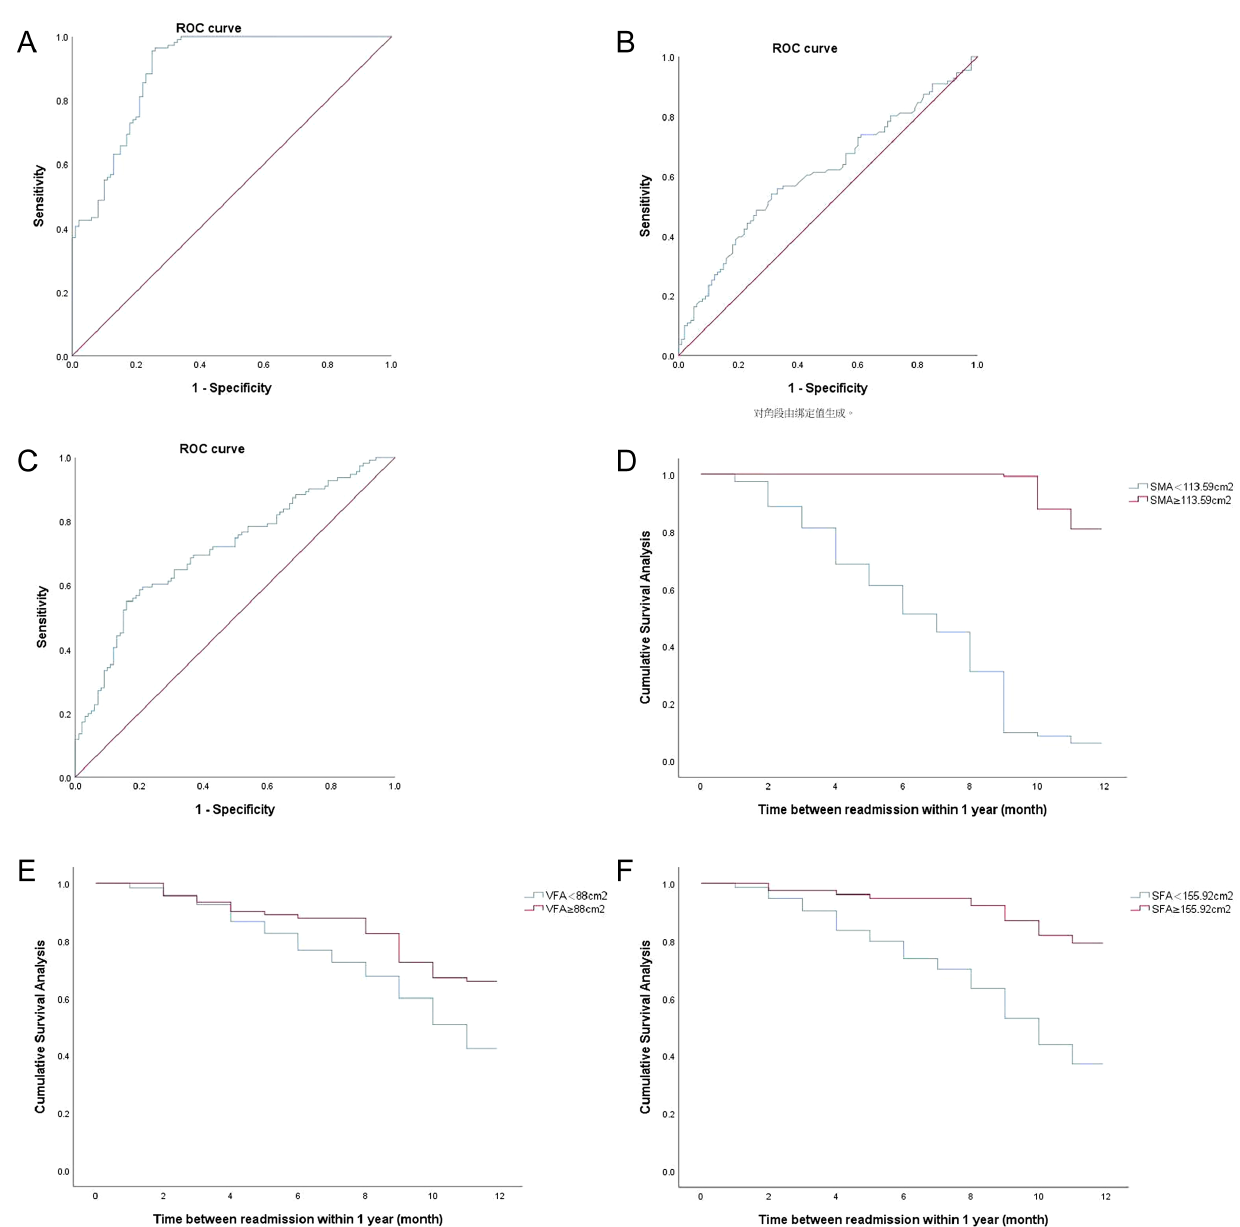
Figure 2. ROC curves of SMA (A), VFA (B), SFA (C), and time to readmission within 1 year. Cumulative survival analysis between in the high group and low group of SMA (D), VFA (E), SFA (F), and time between readmission within 1 year. SMA, skeletal muscle area; VFA, visceral fat area; SFA, subcutaneous fat